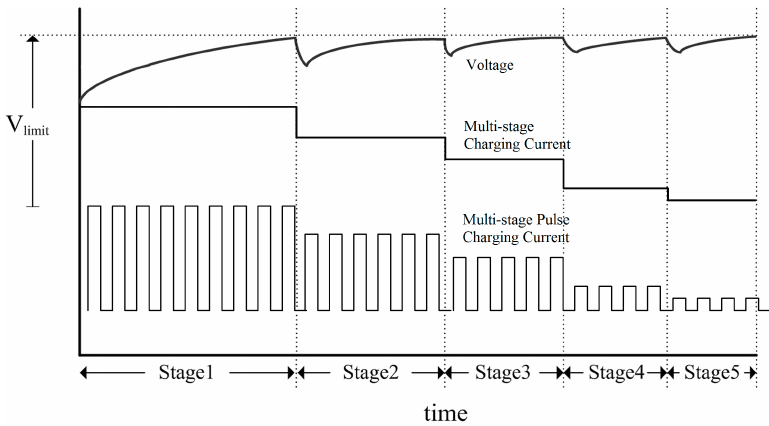
Figure 3. Voltage and current profile of multistage charging and the proposed multistage pulse charging diagram.